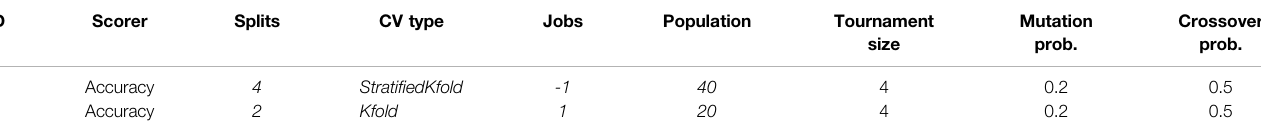
TABLE 2 | Genetic Algorithm parameters.